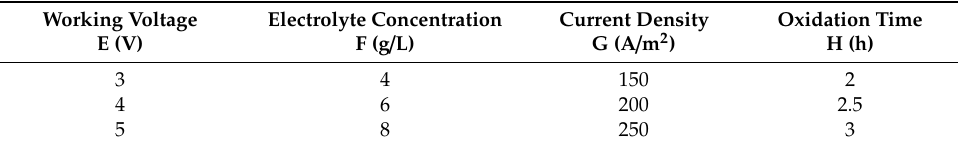
Table 2. Experimental conditions of electrochemical